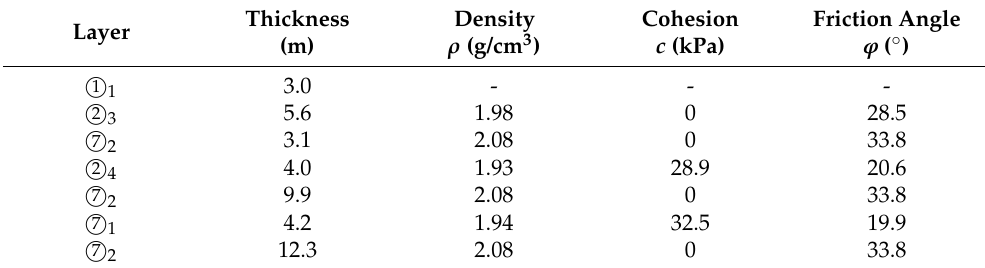
Table 1. Physical and mechanical parameters of each soil layer.